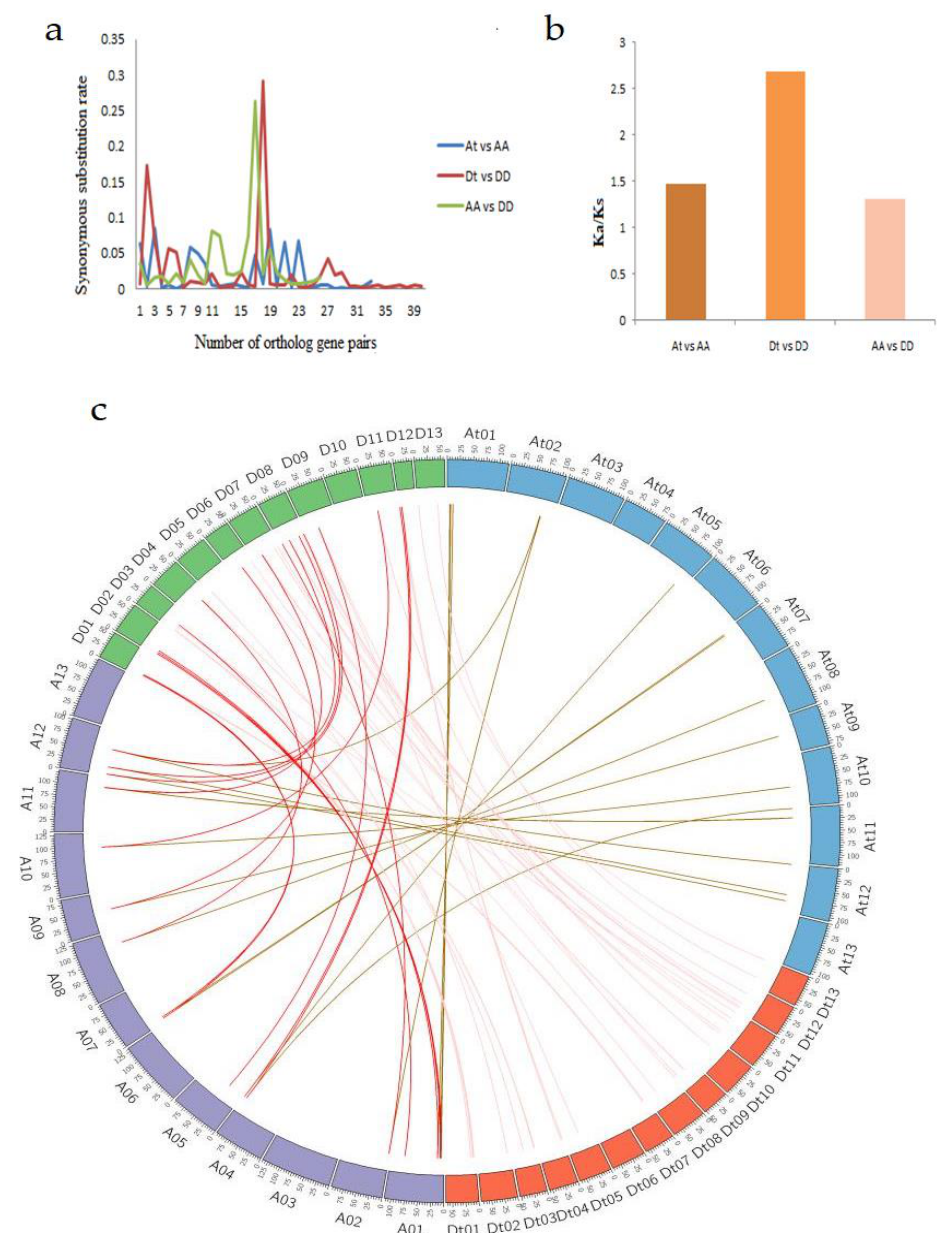
Figure 6. ( a ) Distribution of Ks values for orthologous gene pairs between the A and D genomes and At and Dt subgenomes of G. hirsutum . ( b ) Distribution of Ka / Ks value between the A and D genomes and At and Dt subgenomes of G. hirsutum . ( c ) Syntenic relationships among all homologous genes in At and Dt subgenomes ( G. hirsutum ), D genome ( G. raimondii ) and A genome ( G. arboreum ). Each chromosome in the respective subgenome is shown with the same